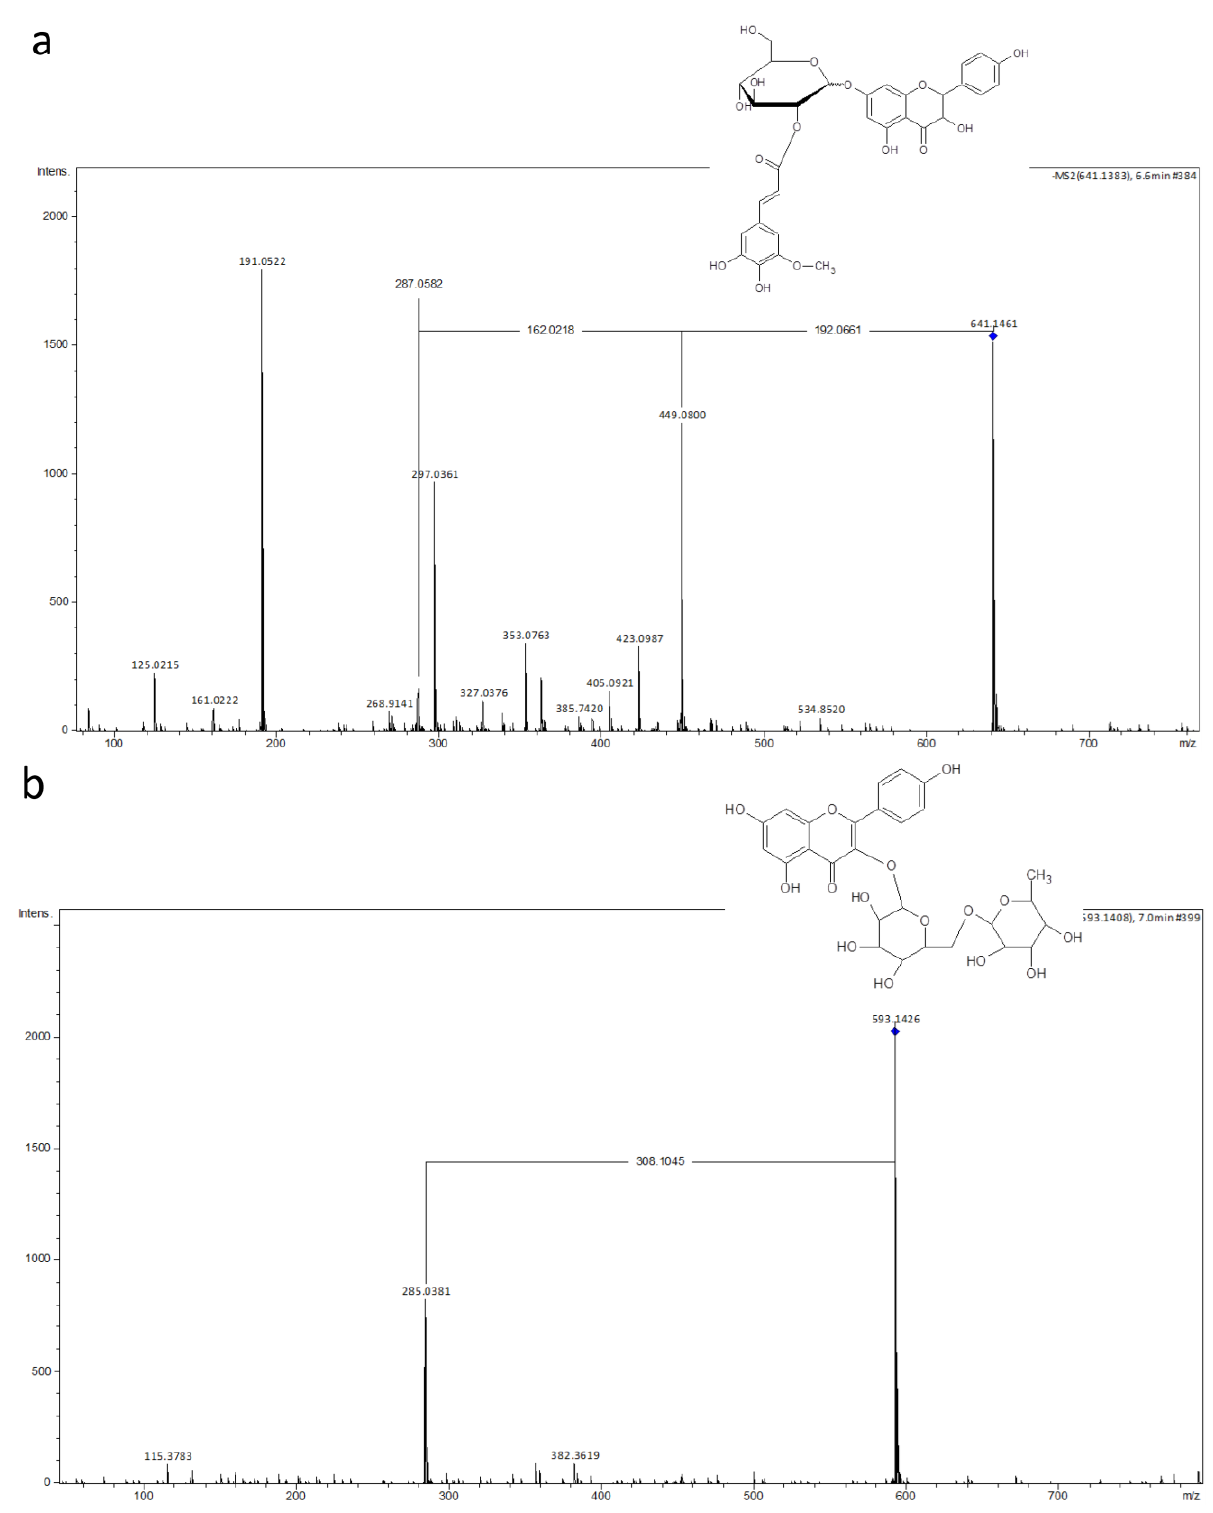
Figure 4. Spectra of two selected flavonoids identifed after LC-MS analysis of post culture medium of Cyathea delgadii : ( a ) Aromadendrin 7-O-(hydroxyferuloyl-glucoside); ( b ) Kaempferol 3-O-rutinoside (rhamnosyl-glucoside).